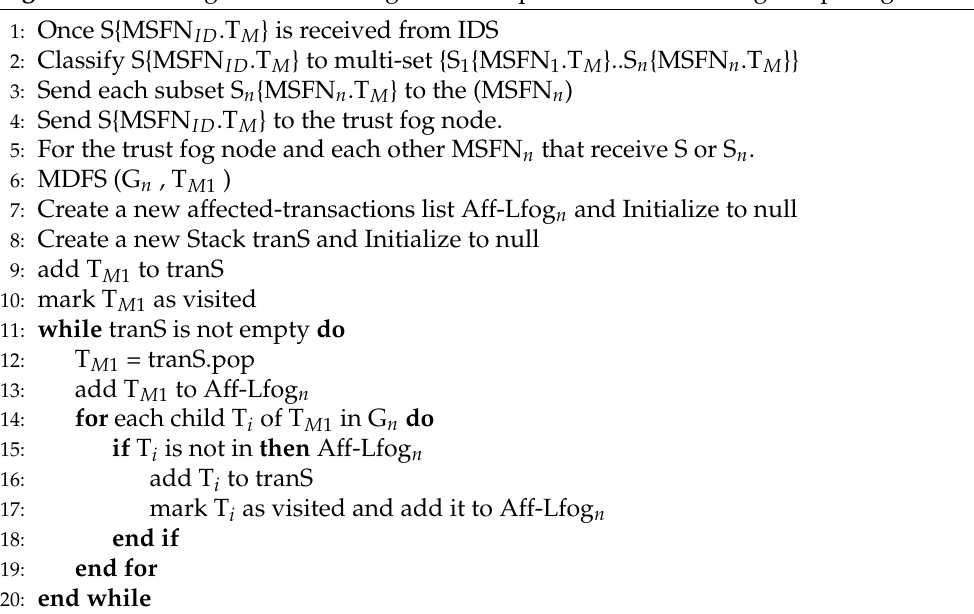
Algorithm 3 Damage assessment algorithm for private distributed fog